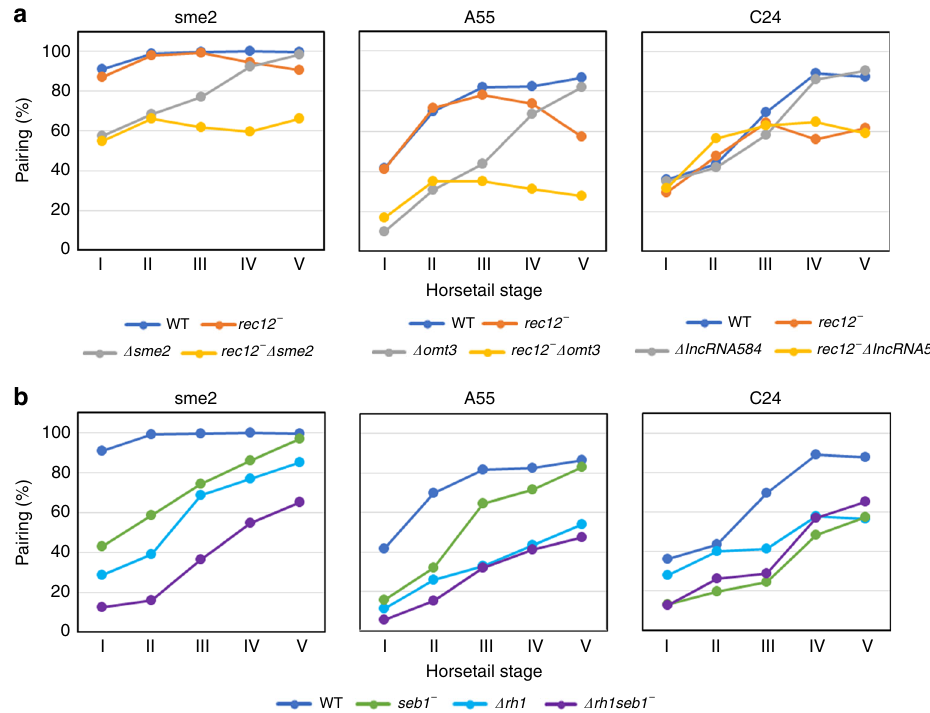
Fig. 4 Homologous chromosome pairing at lncRNA accumulation sites. a , b Pairing frequencies were plotted for fi ve substages (I – V). Pairing frequency (%) at the sme2 , A55, and C24 loci in WT (blue), rec12 − (orange), Δ sme2 , Δ omt3, and Δ lncRNA584 (gray), Δ sme2 rec12 − , Δ omt3 rec12 − , and Δ ncRNA.584 rec12 − (yellow) Δ rhn1 (light blue), seb1 − (green), and Δ rhn1 seb1 − double mutants (purple) was measured in 18 – 53 cells for each strain; the precise number of cells examined for each strain is provided in Source Data fi le 4. Percentile rank plots of the distance between homologous loci are shown in Supplementary Fig. 5. Source data for Fig. 4 and Supplementary Fig. 5 and are provided as a Source Data fi le